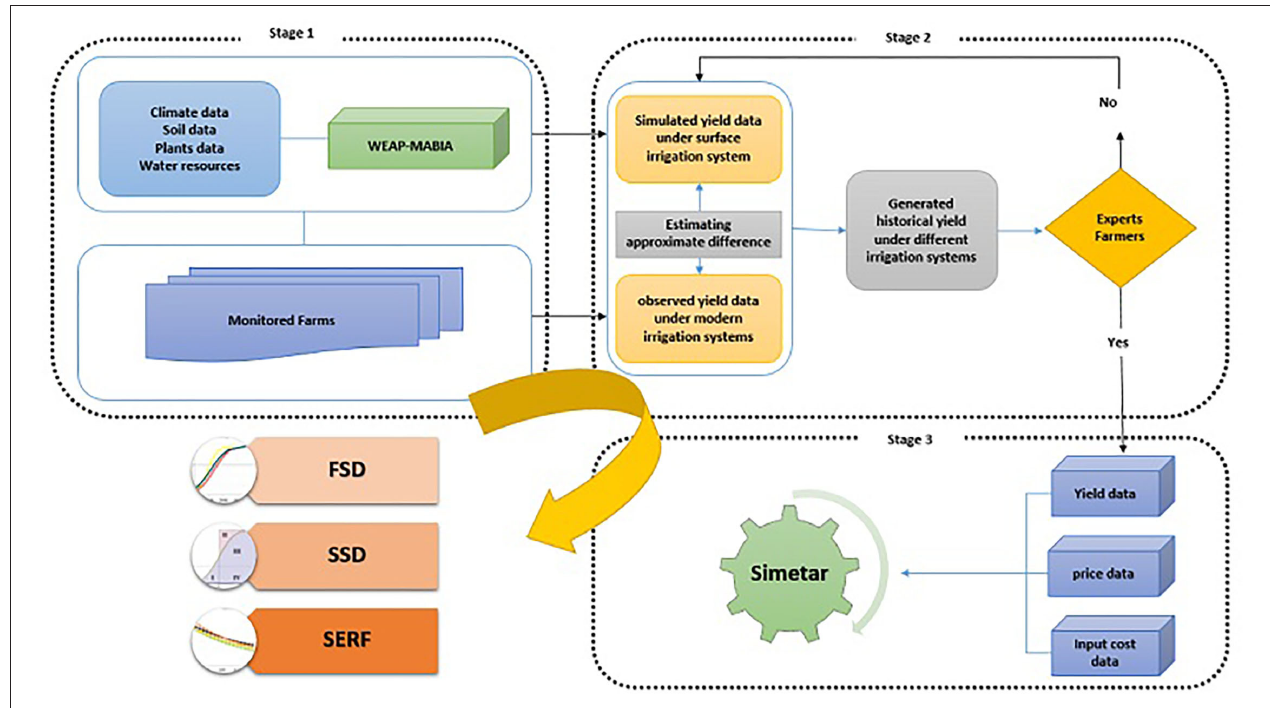
FIGURE 1 | The analysis stages